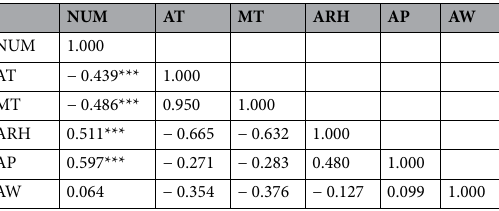
Table 1. Correlation analysis of NUM, AT, MT, ARH, AP, and AW, where the values represent correlation, and ***means that p-value is less than 0.01, that is, there is significant correlation between variables.